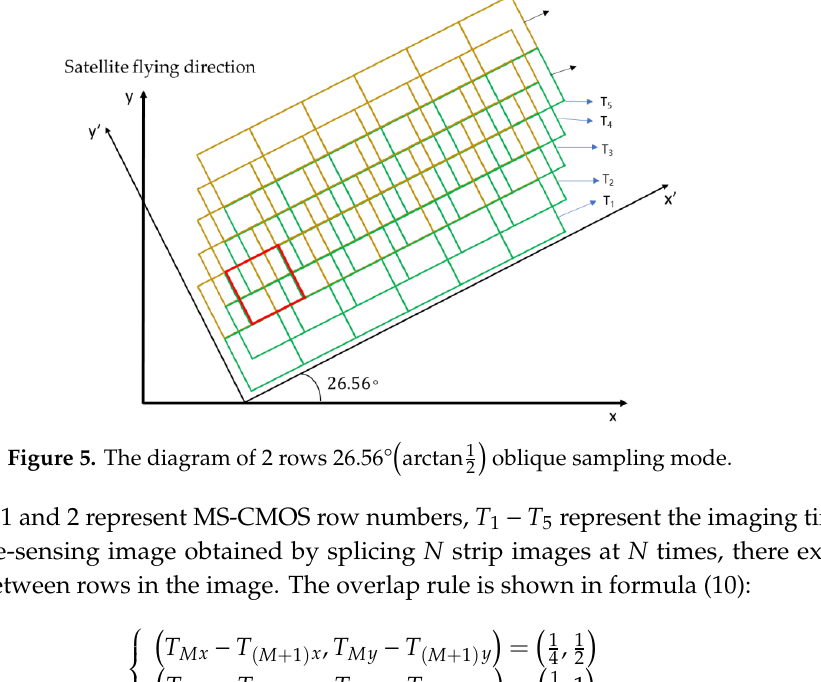
Figure 5. The diagram of 2 rows 26.56 ° (arctan 1